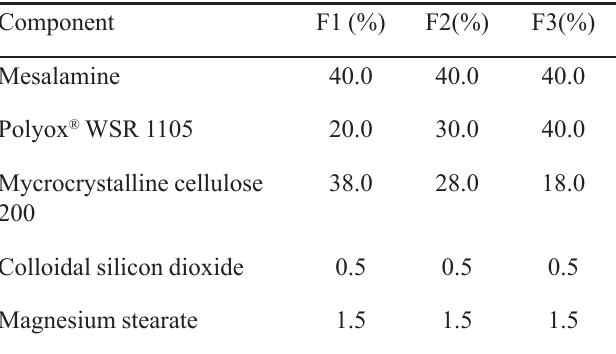
TABLE I – Composition of minitablet